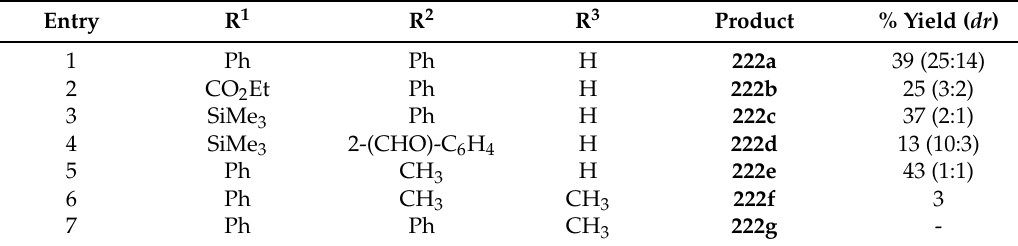
Table 30. Reaction of benzaldehyde-derived imines 210 with difluorocarbene and aldehydes 2 or ketones 3 , yielding oxazolidinones 222 (Scheme 63).